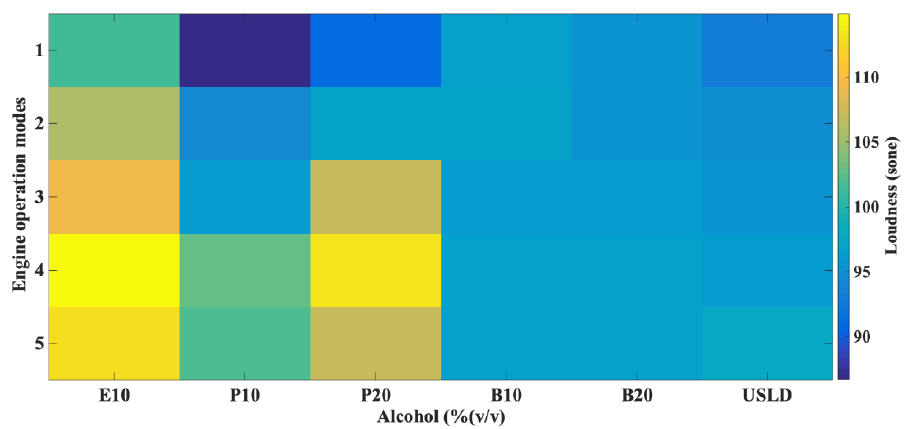
Figure 9. Loudness for alcohol diesel fuel blends; 10% ( v / v ) ethanol/diesel fuel (E10), 10% ( v / v ) propanol/diesel fuel (P10), 20% ( v / v ) propanol/diesel fuel (P20), 10% ( v / v ) butanol/diesel fuel (B10), 20% ( v / v ) butanol/diesel fuel (B20) and 100% ultra-low -sulfur diesel fuel (USLD).